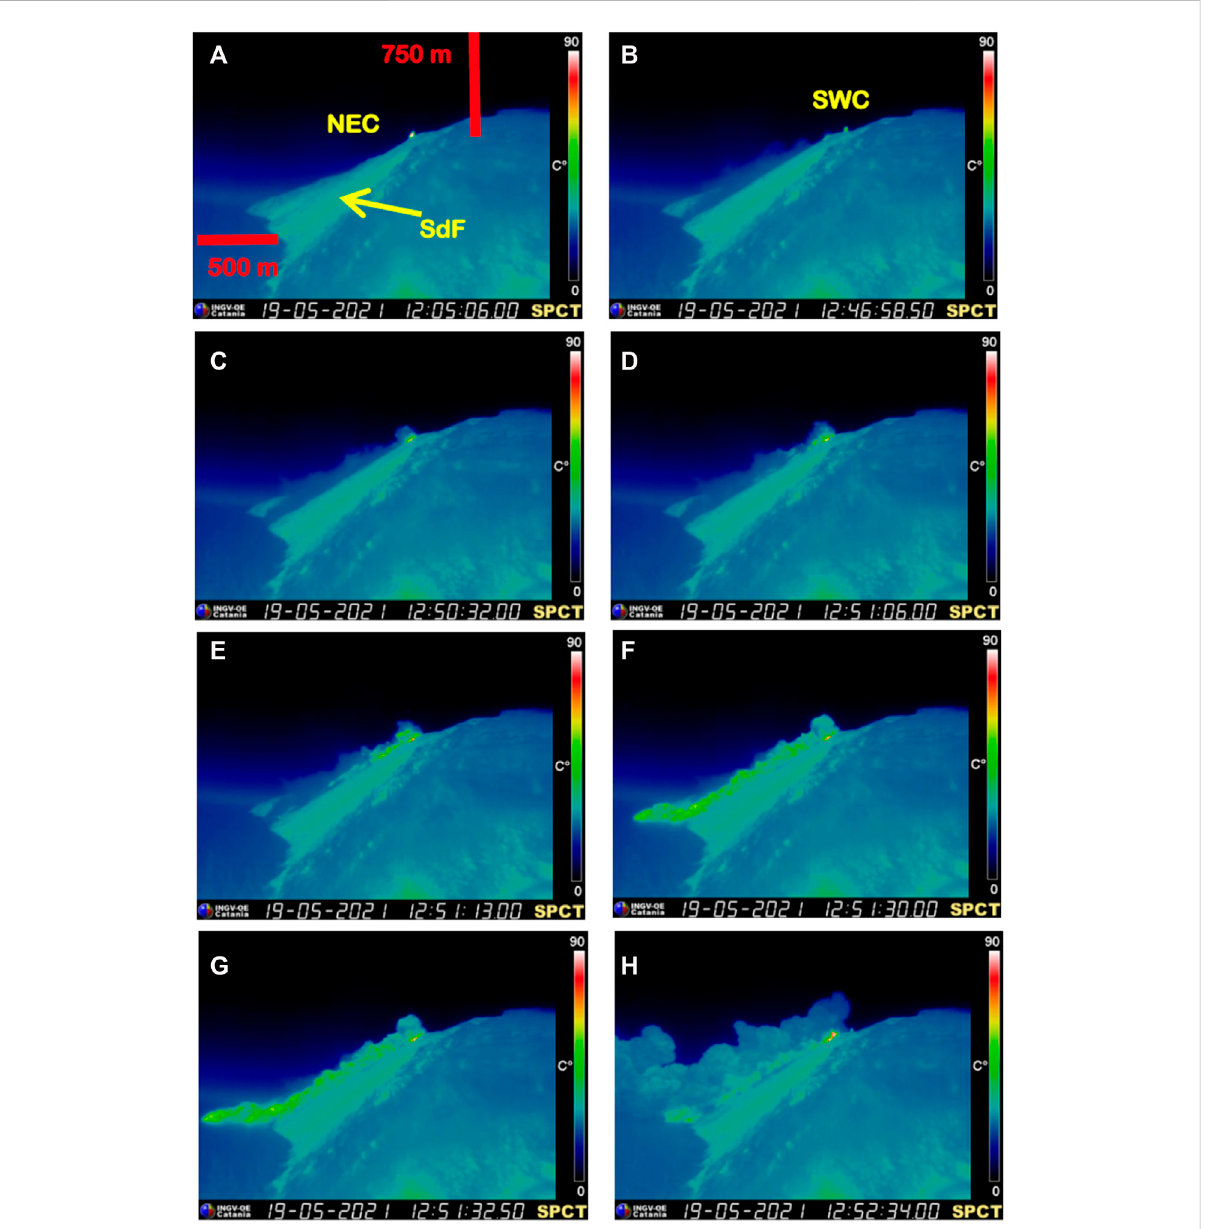
FIGURE 4 Thermal images from the SPCT monitoring camera with a view from the West fl ank of the Sciara del Fuoco of the sequence of NEC failure on 19May2021 at~12:51.Thetemperaturescalebetween0and90 ° Cisontherightofeachframe. (A) StrombolianexplosionfromtheNECoccurredat 12:05:06, with vertical and horizontal scales of the image displayed in red — note that at this stage the Sciara del Fuoco slope (SdF) was clean; (B) Strombolian explosion from the SWC occurred at 12:46:58 – at this stage the SdF slope was affected by a dust cloud (in blue in the image) extending from the NEC to the coast; (C) over fl ow from the NEC triggering an initial failure of the crater fl ank at 12:50:32; (D) a hot avalanche or pyroclasticdensitycurrent(PDC)startedfromtheNECduetothefailureofthecrater fl ankat12:51:06; (E) thePDCspreadalongtheSdFreachinghalf wayalongtheslopeat12:51:13; (F) thePDCstartedspreadingontheseasurfacefor~300 mdistancefromthecoastat12:51:30; (G) thePDCtraveled ~500 m on the sea surface at 12:51:32.50; (H) dust and steam cloud caused by the PDC entering the sea and the lava fl ow spreading along the SdF slope spread upwards towards the craters at